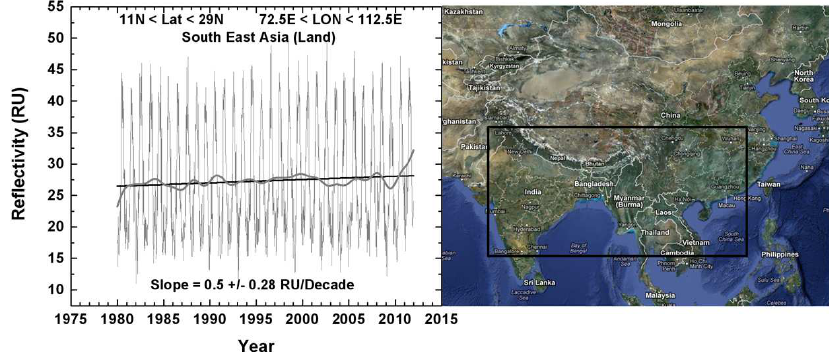
Fig. 16. LER( θ , ϕ ) and 1 LER( θ , ϕ ) for the indicated latitude × longitude box showing the increase in LER over India, southern China, and Indochina. Both daily data and 365-day low-pass filter are